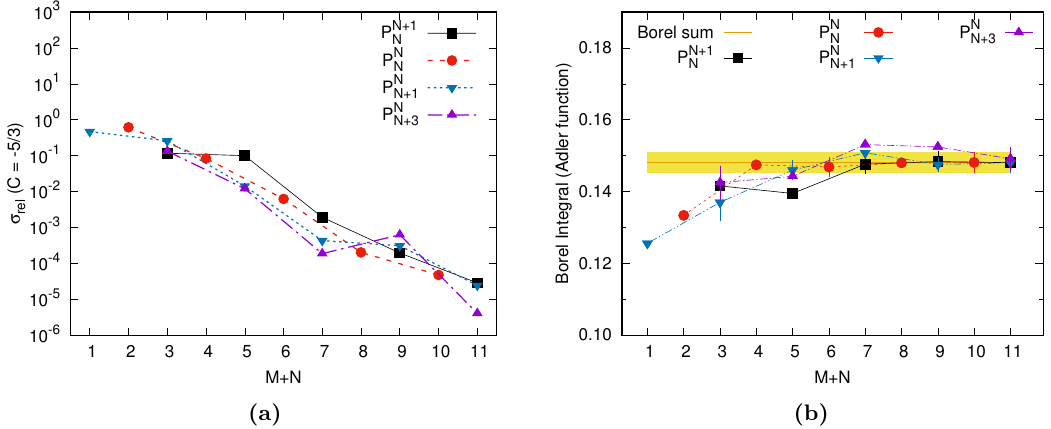
Figure 5. Results for di(cid:11)erent Pad(cid:19)e sequences in a scheme with C = (cid:0) 5 = 3. The scales are the same as in (cid:12)gure 3 to facilitate the comparison. (a) Relative error of the (cid:12)rst forecast coe(cid:14)cient of the Adler function. (b) Results for the Borel sum, eq.